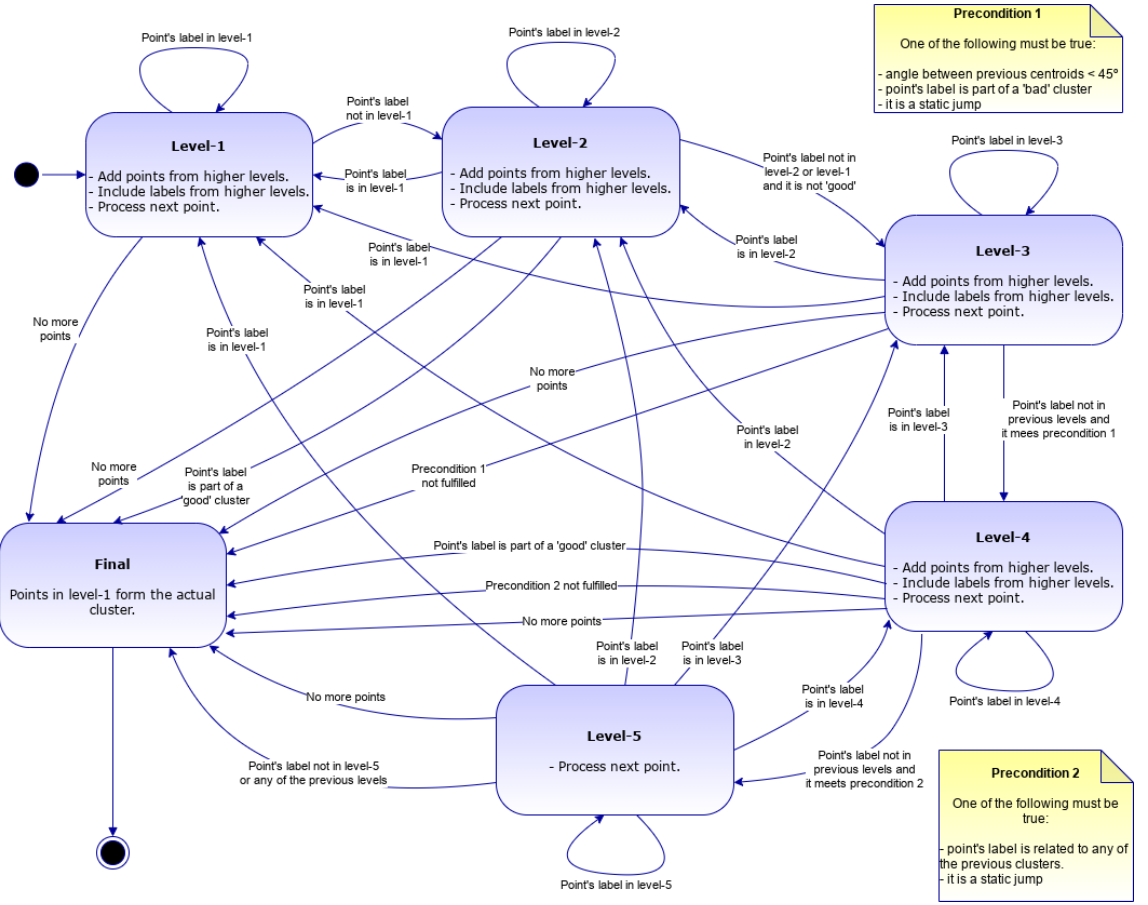
Figure 6. State diagram of the multi-clustering